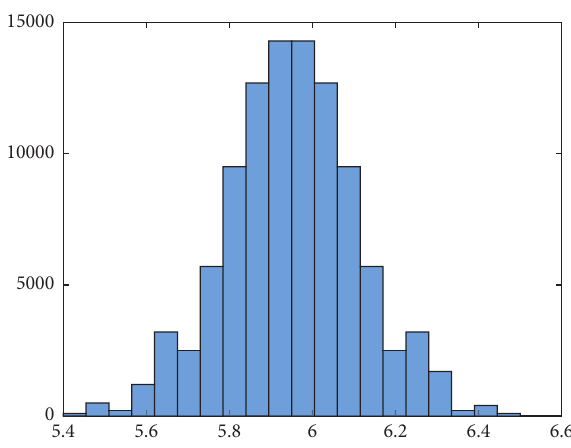
Figure 7: The statistical data of cross section of Table 3: Relative error and execution time of different methods.